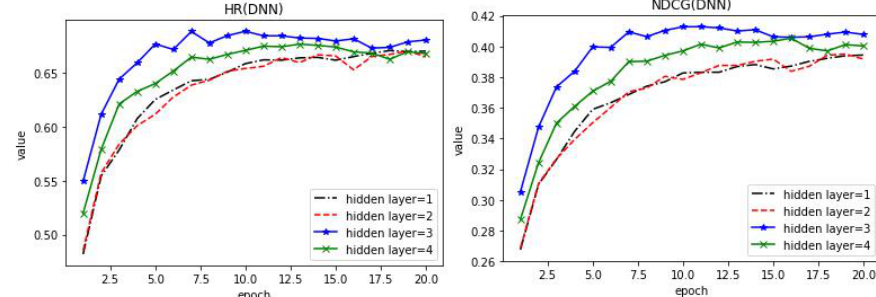
Figure 6. The MAP and NDCG values for different numbers of hidden layers.